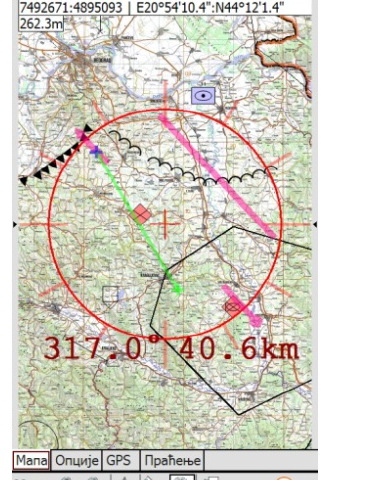
Figure 1 – Example from the mobile GIS Forward Observer module (the crossed, red, diamond shaped signs describe an enemy infantry